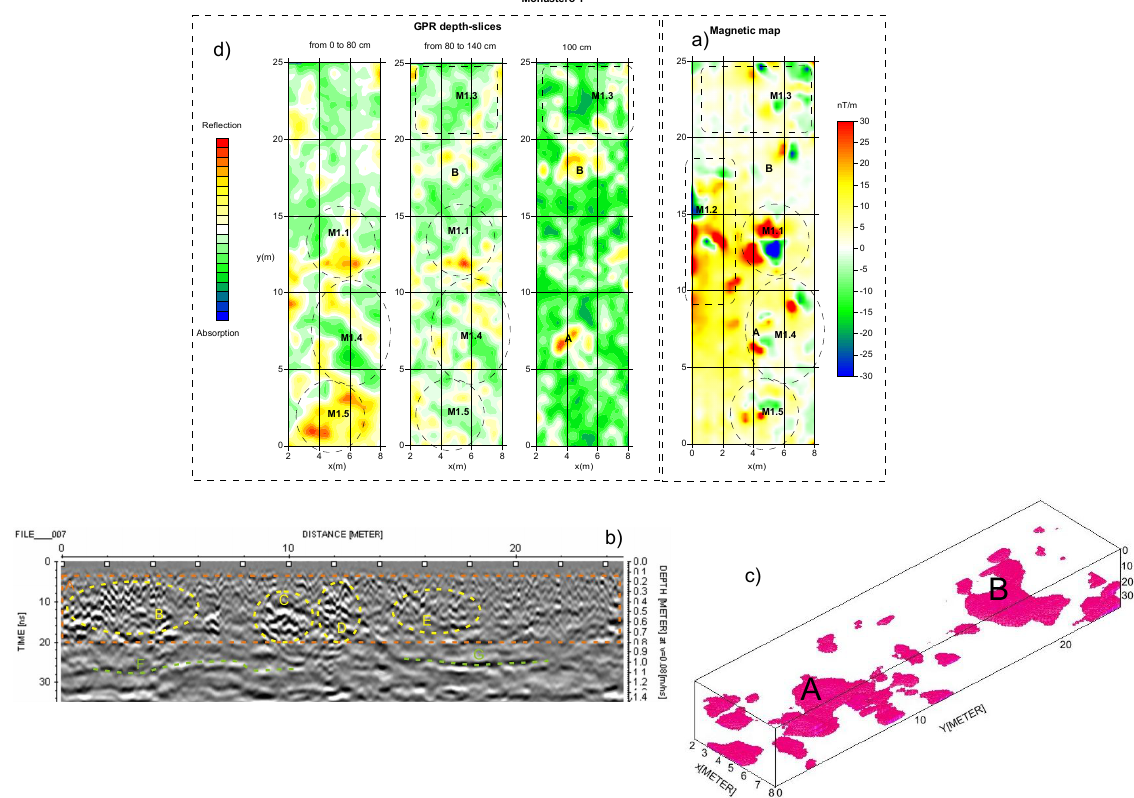
Fig. 5. Geophysical data acquired in “Monastero1” site. (a) magnetic map; (b) radargram; (c) GPR data volume; (d) depth-slices built from 0 to 80cm of depth, from 80cm to 140cm of depth and at 100cm of depth. Labels explanation in the text.